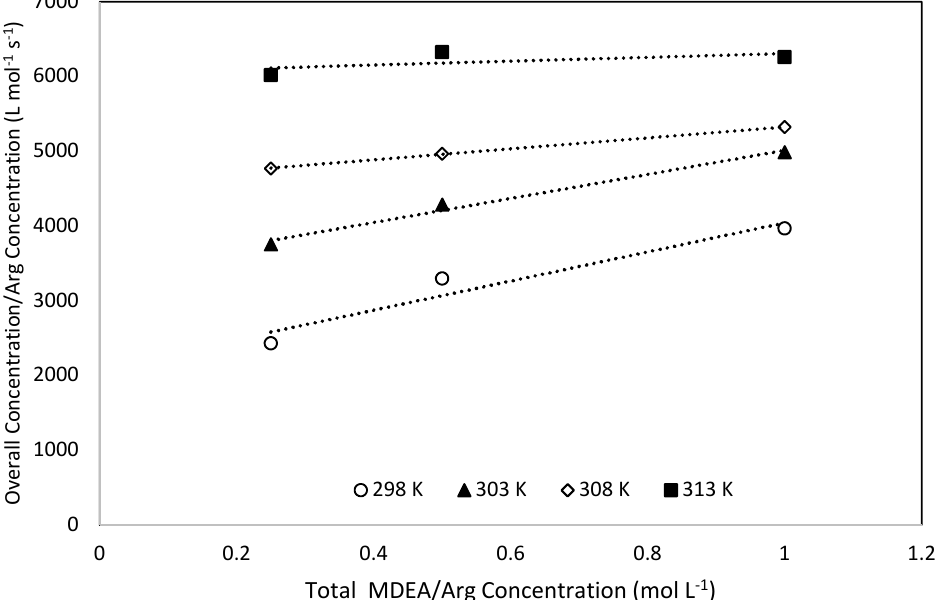
Figure 7. Termolecular mechanism applicability Test for 0.025 M L-Arginine concentration.